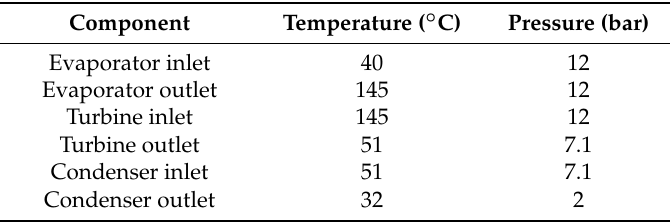
Table 6. ORC system parameters at a power output of 1.5